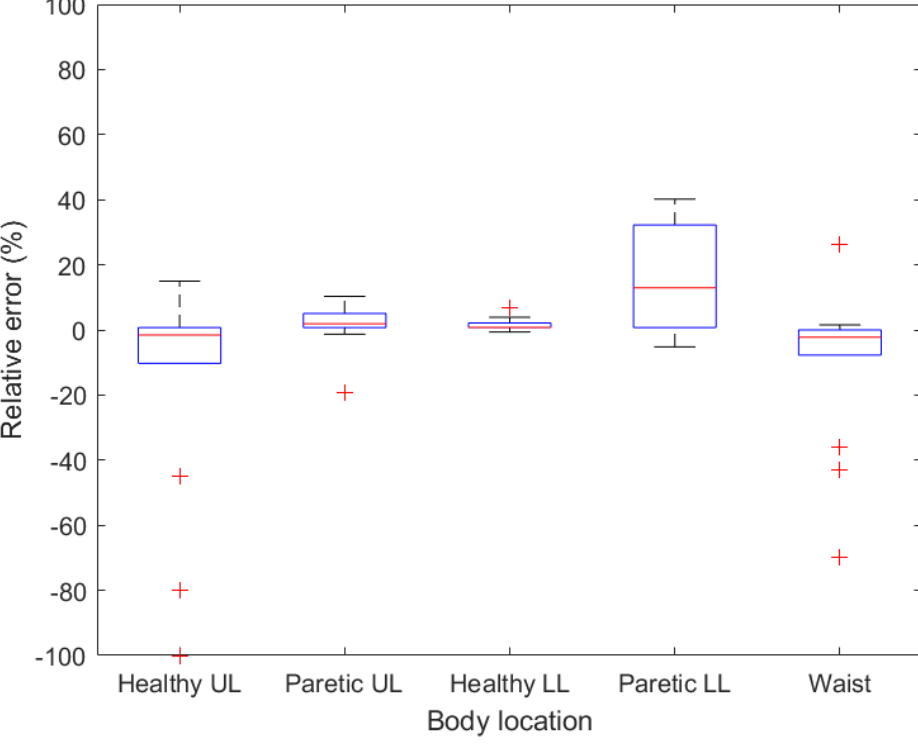
Figure 5. Boxplots demonstrating relative error for given body location when a single-point stick is used. UL—upper limb, LL—lower limb.